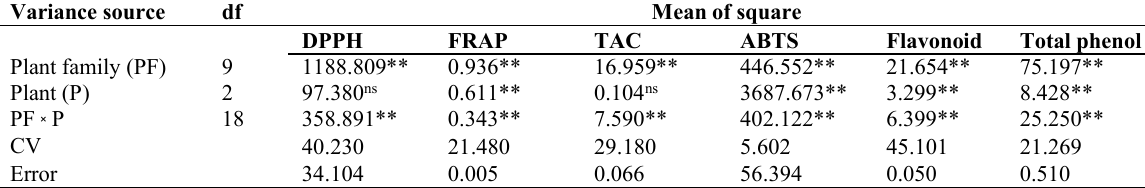
Table 2. Variance analysis of measured characteristics in studied plant species. Variance source